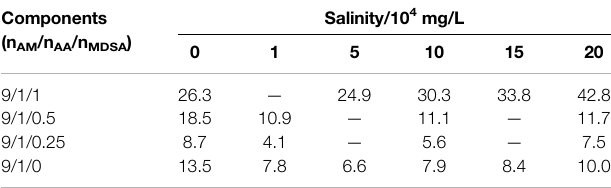
TABLE 1 | Viscosity (mPa · s) of HPAM and zwitterion-modi fi ed HPAM at 90 ° C. Components (n AM /n AA /n MDSA